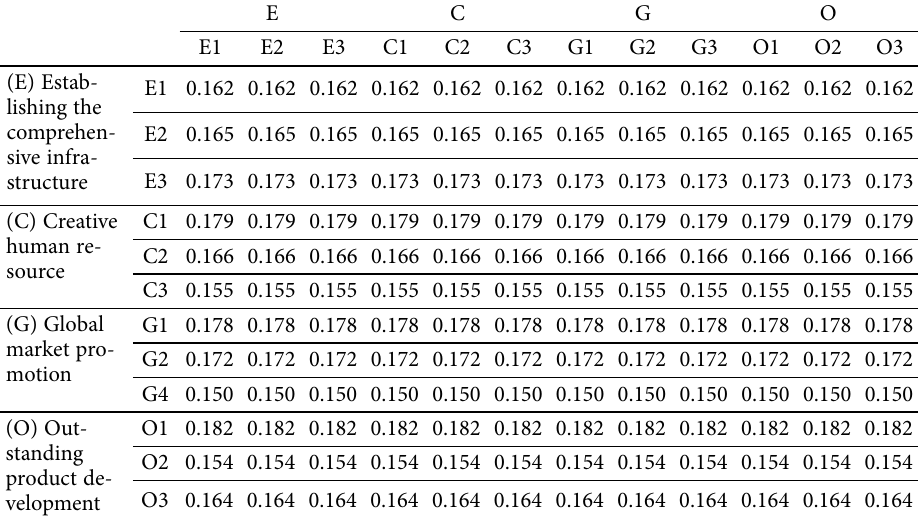
Table 5. The limiting